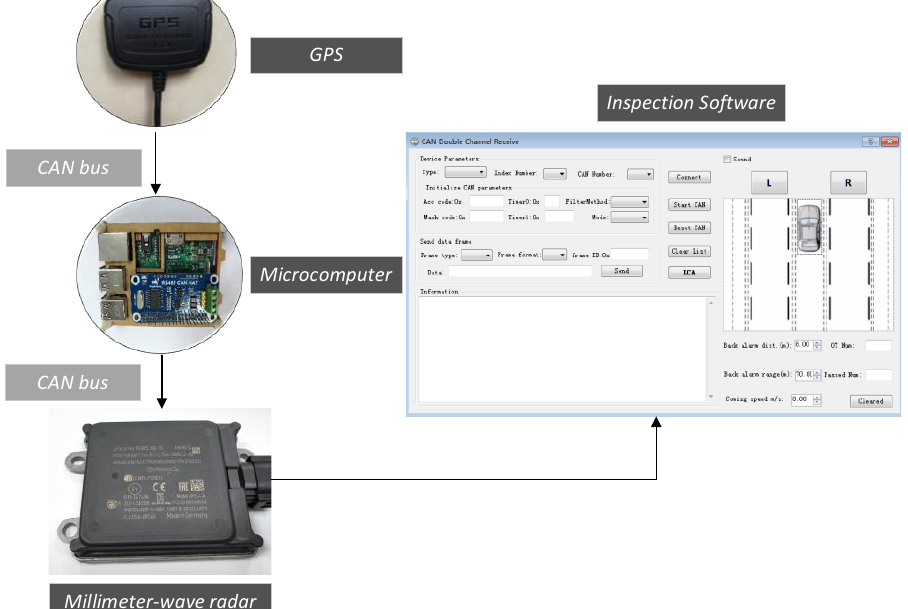
Figure 5. Experimental equipment.